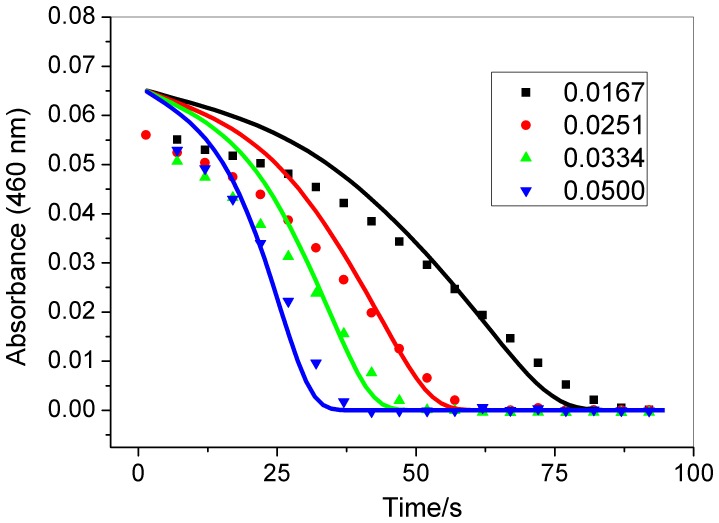
Effect of chlorate concentration (indicated in the figure – mol L−1) in the clock time.Other initial concentrations: [HClO4] = 0.948 mol L−1; [I2] = 8.80×10−5 mol L−1; [HNO2] = 1.15×10−3mol L−1. Experimental (symbols); simulation (continuous lines). Experimental data point were measured at every 5 s.